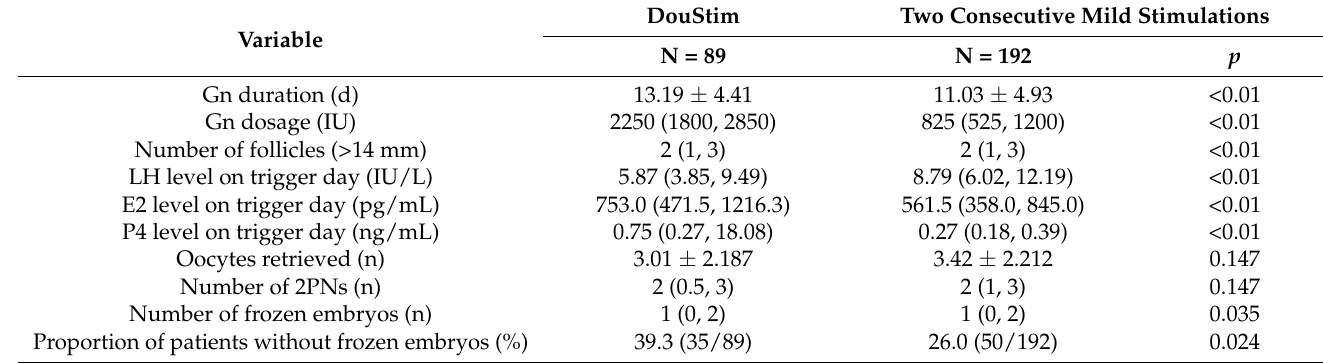
Table 2. Comparison of clinical observation indexes between the DouStim group and the two consecutive mild stimulations